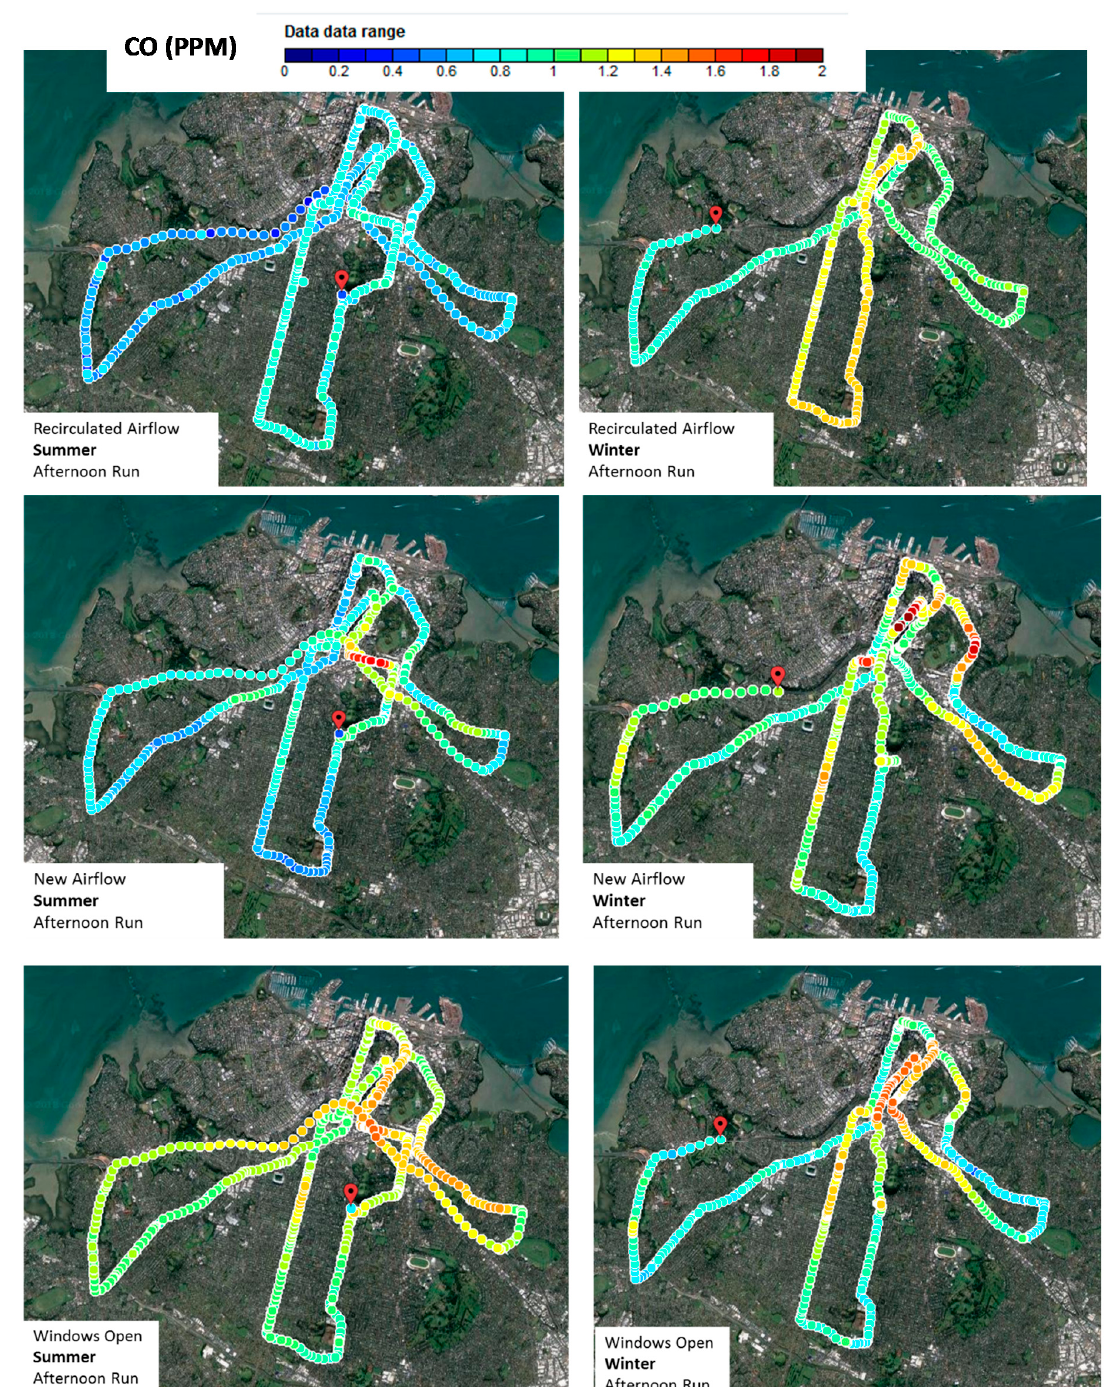
Figure 5. Afternoon 10-s averaged CO concentrations. Data from the summer on the left and winter on the right. The ventilations settings are: “Recirculate” ( top ), “new air” ( middle ), and “windows open” ( bottom ). The CO ppm range is shown in the legend at the top of the first graph and is consistent throughout the three graphs.